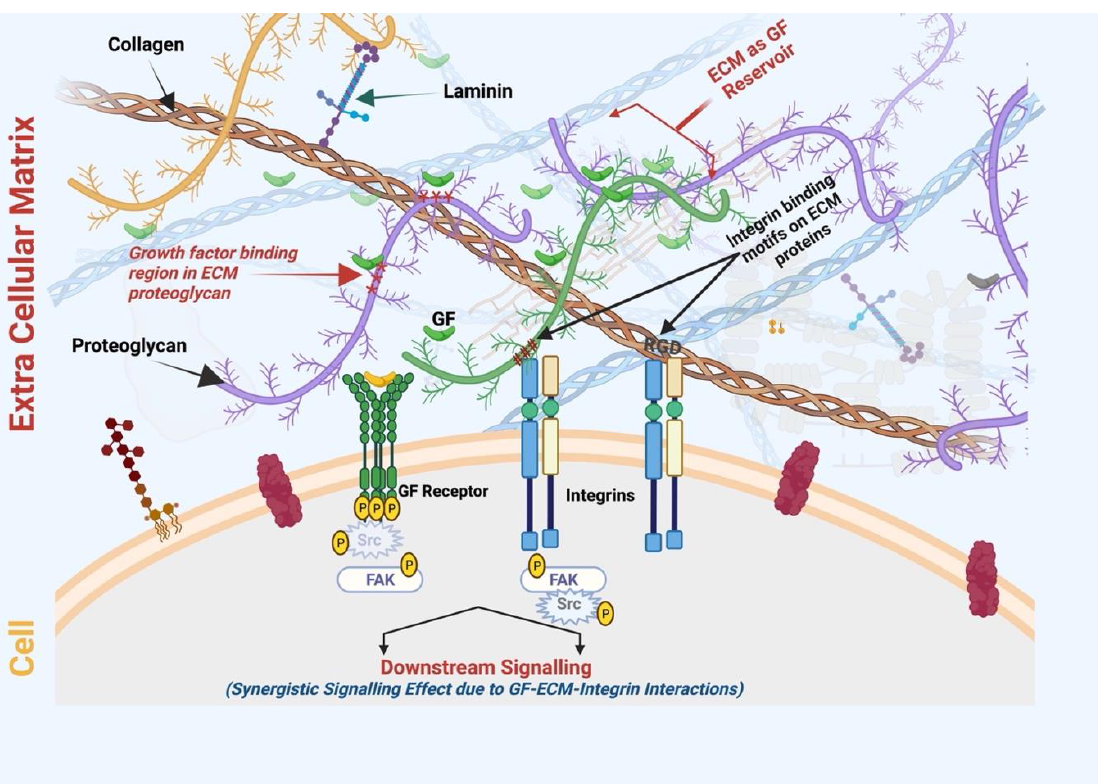
Figure 4. ECM act as GF reservoirs where proteoglycans contain GF binding domain/regions. Various ECM proteins such as collagen and fibronectin contain integrin-binding motifs (for example, RGD or the Arg-Gly-Asp motif) that bind to the cell surface integrin receptor. Therefore, ECM-scaffold-mediated GF delivery can simultaneously induce the signaling cascades of integrins and growth factor receptors, resulting in increased and prolonged GF signaling. SMILE-derived ECM-scaffold-mediated GF delivery can be exploited for its synergistic wound healing/regenerative therapies at a lower dose of GF (Figure created using BioRender.com, BioRender, Toronto, ON, Canada).